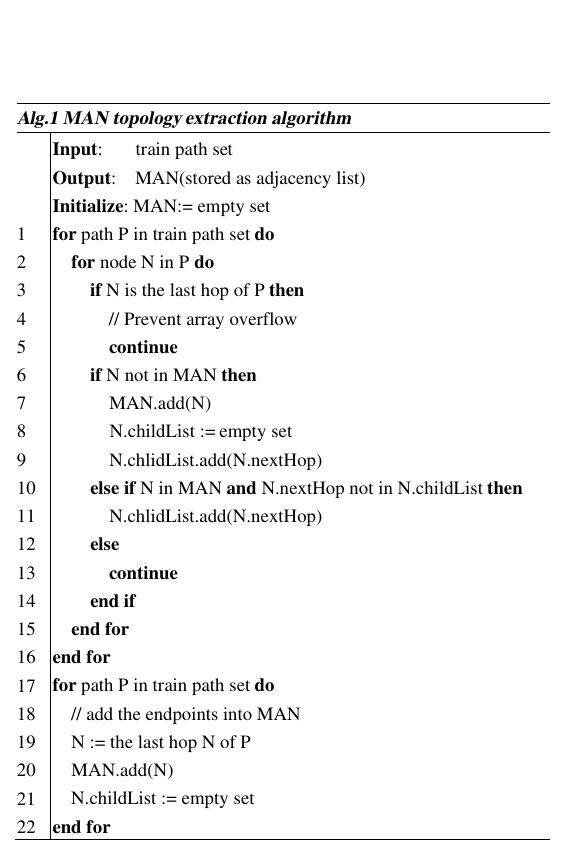
Table 1. Comparison of different IP detection